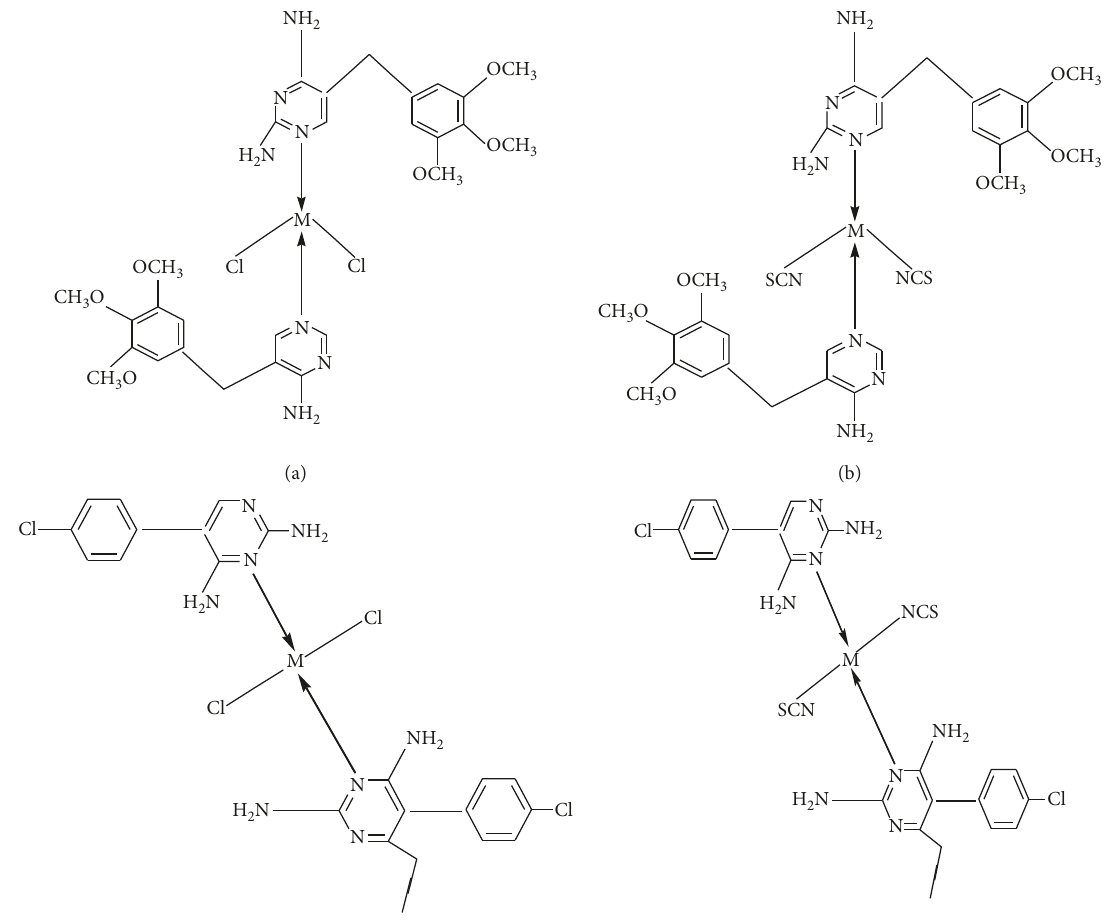
Figure 10: Palladium complex with diaminopyrimidine ligands (where M � palladium or platinum).